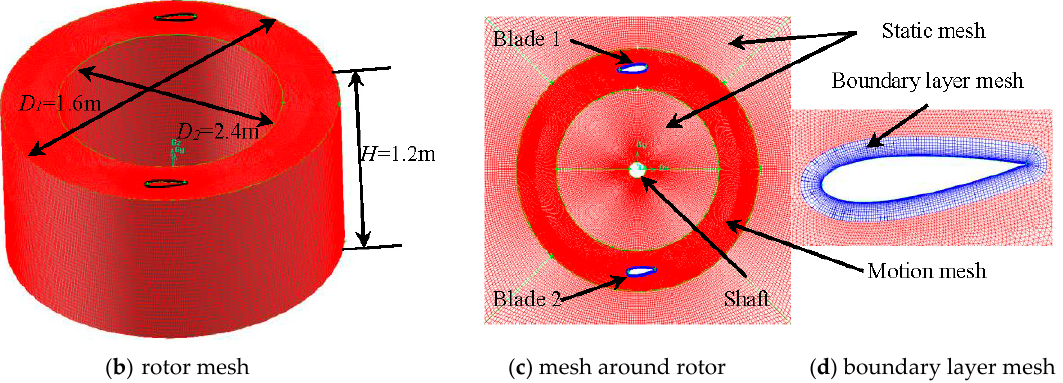
Figure 3. Numerical region and mesh strategy for the VAWT: ( a ) show entire mesh domain, ( b ) rotor mesh, ( c ) mesh around rotor and ( d ) boundary layer mesh, respectively.